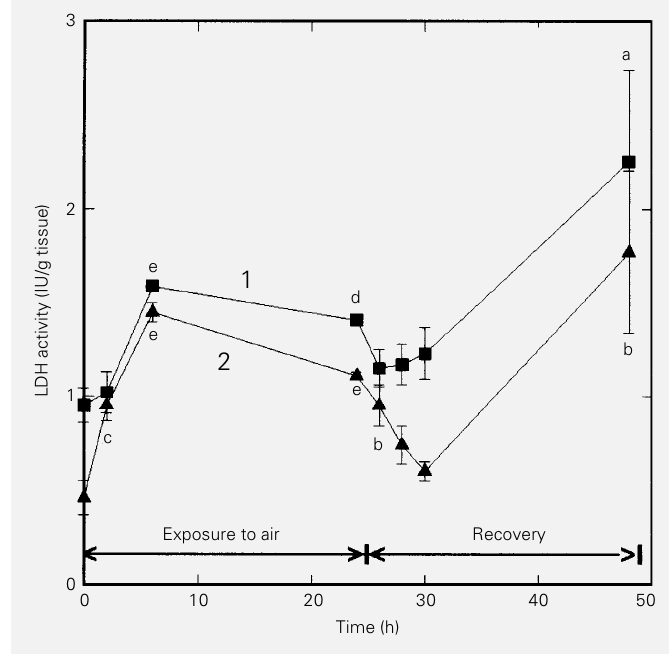
Figure 2 - Effect of exposure to air and recovery on lactate dehydrogenase (LDH) activity measured at saturating concentrations (1 mM pyruvate and 160 (cid:181)M NADH, curve 1) and low pyruvate concentration (0.2 mM pyruvate and 160 (cid:181)M NADH, curve 2). Data are reported as means – SEM for four individuals. Significantly different from (cid:147)zero(cid:148) time with a P<0.05, b P<0.025, c P<0.01, d P<0.005, and e P<0.001,